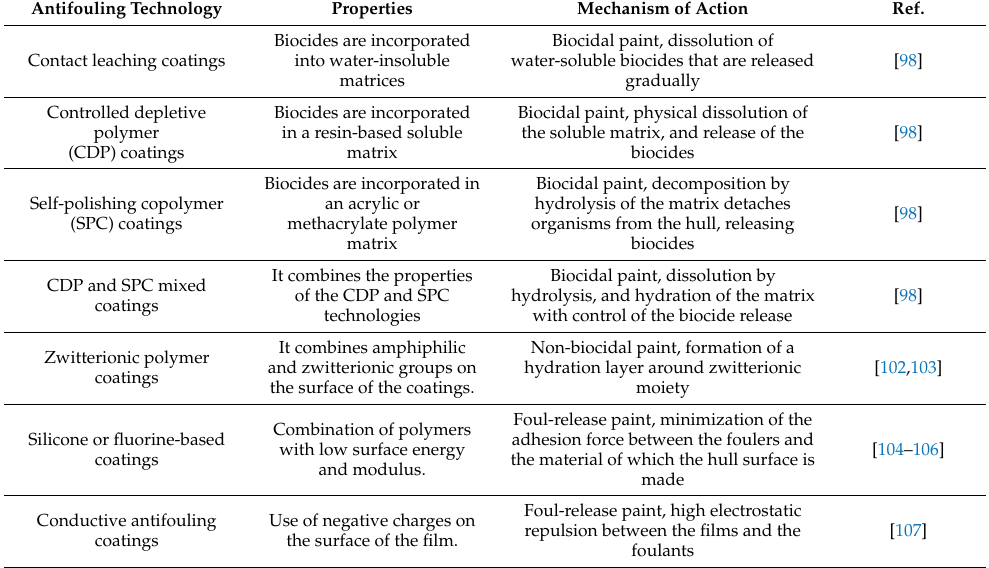
Table 4. Different antifouling technologies for